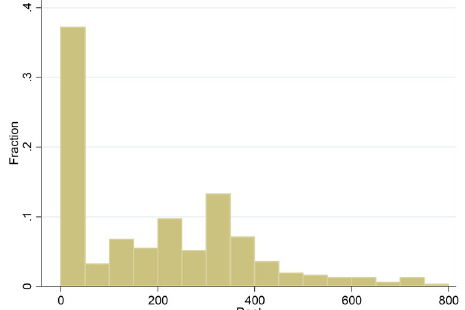
Fig. 6 Distribution of monthly rent (RM). Respondents distribution by monthly rent (RM).